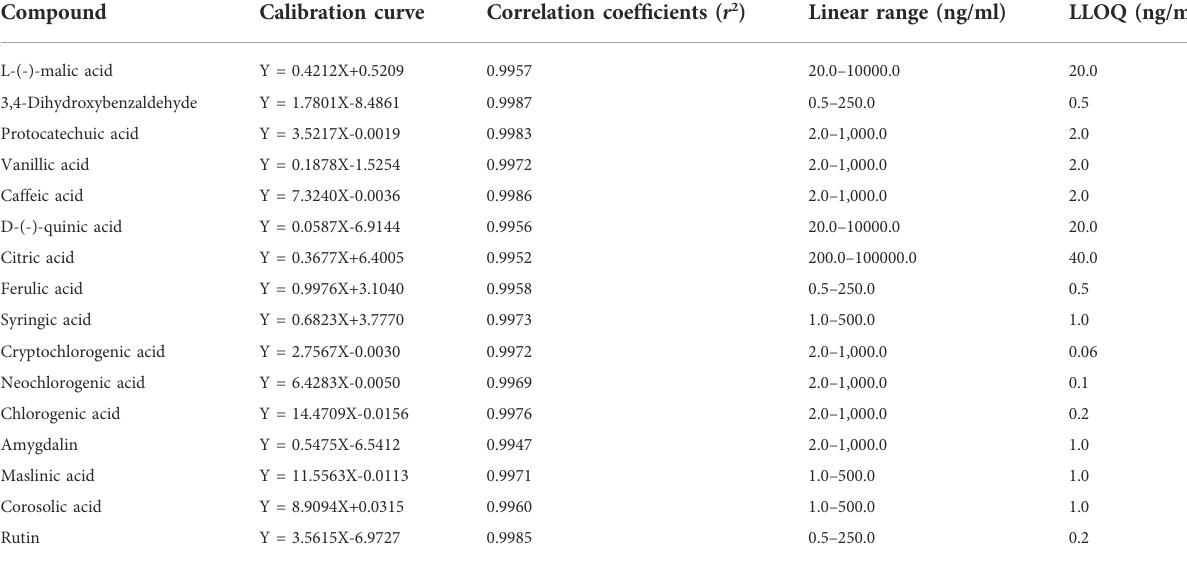
TABLE 1 Calibration pro fi les, linear ranges, correlation coef fi cients and LLOQ of the 16 analytes.